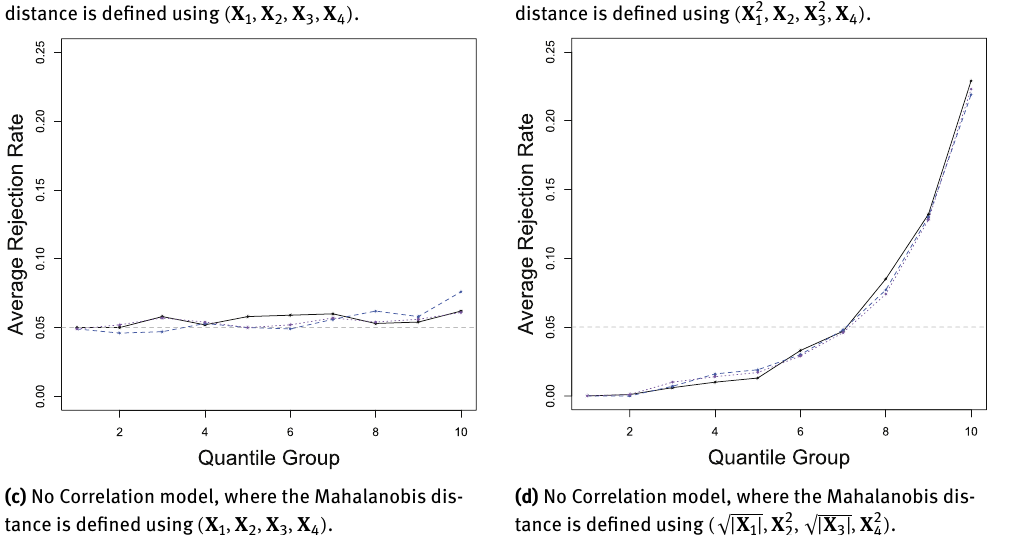
, X 2 , √ | X | , X 2 ) for the Moderate Correlation and No Correlation models, 1 3 2 4